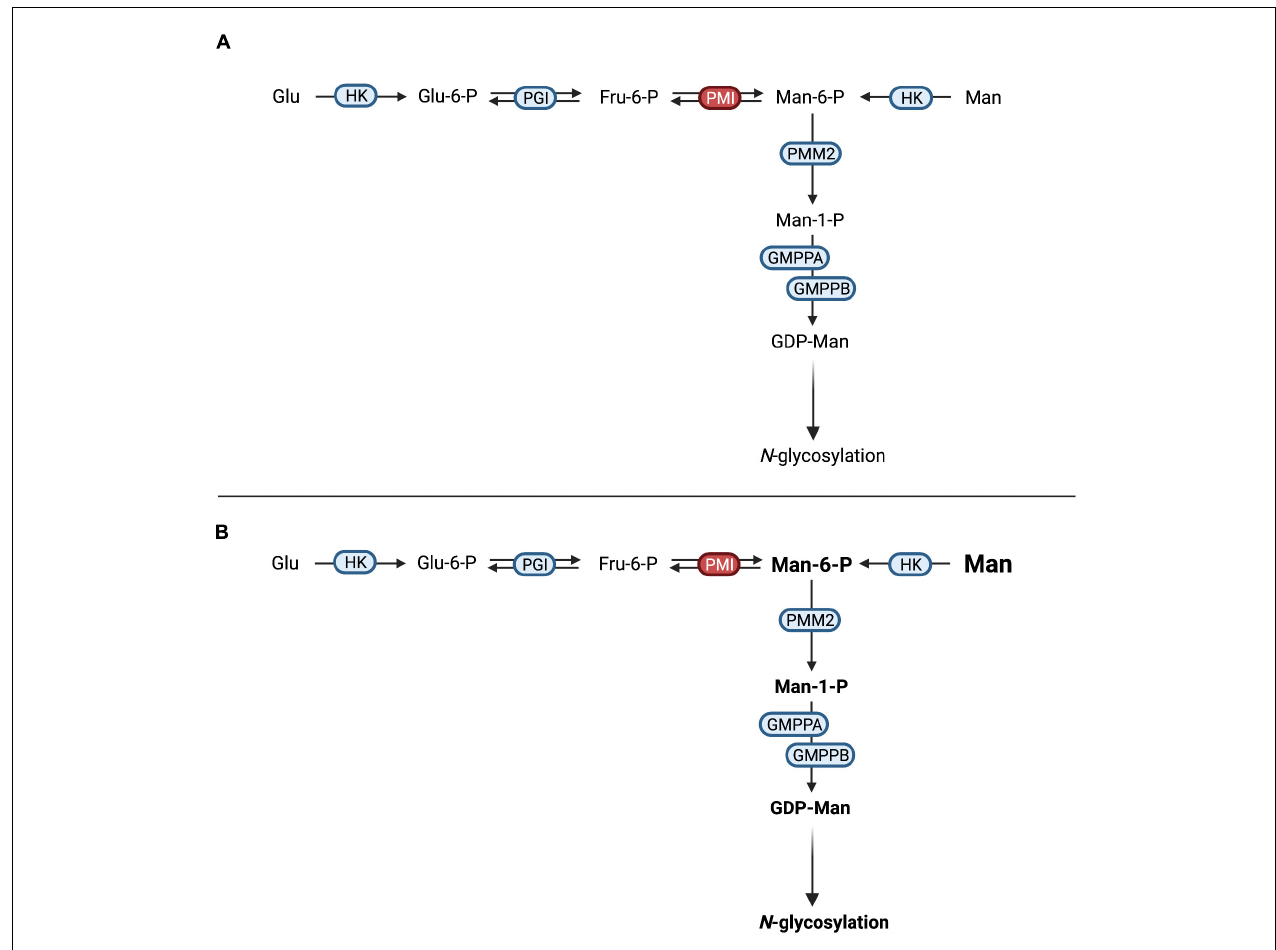
FIGURE 3 | Mannose therapy in MPI-CDG. (A) Mutations in MPI lead to an impaired function of phosphomannose isomerase (PMI), thus hindering the interconversion of fructose-6-phosphate (Fru-6-P) to mannose-6-phosphate (Man-6-P). (B) The oral supplementation of mannose increases the available Man-6-P following conversion of mannose (Man) by hexokinase (HK). After conversion of Man-6-P to mannose-1-phosphate (Man-1-P) by phosphomannomutase 2 (PMM2), conversion into guanosine diphosphate-mannose (GDP-Man). This can be used in N